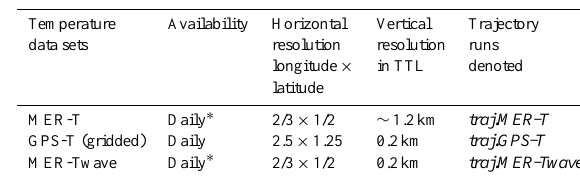
Table 1. Different temperature data sets used in trajectory